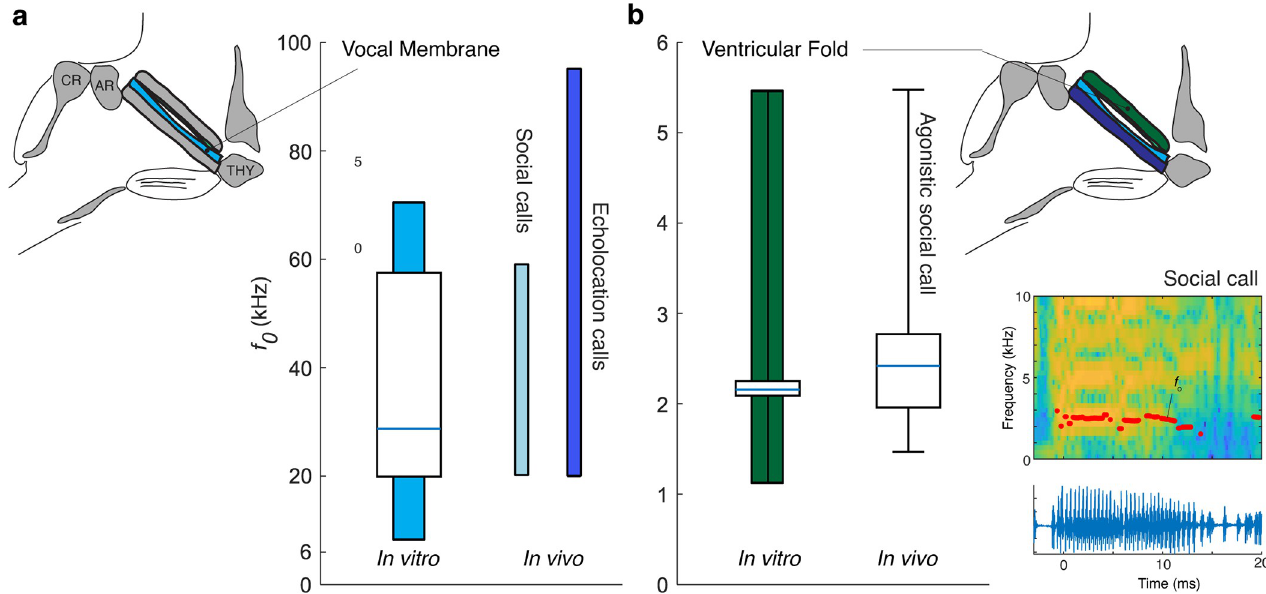
Fig 4. The vocal range of laryngeal structures in vitro corresponds to frequency ranges of distinct social calls in Daubenton’s bat. (a) Vocal membrane f range in vitro (blue vertical bar) compared to reported in vivo range for social [8] and echolocation calls [24] of M . daubentonii . (b) Ventricular fold f o range in vitro (green vertical bar) corresponds well to f range of agonistic social calls of M . daubentonii . Boxplot whiskers indicate range. For values see S2 Table. Inset o shows a spectrogram and oscillogram of an agonistic social call. Abbreviations as in Fig 1. The data underlying a and b can be found in S6 Data.